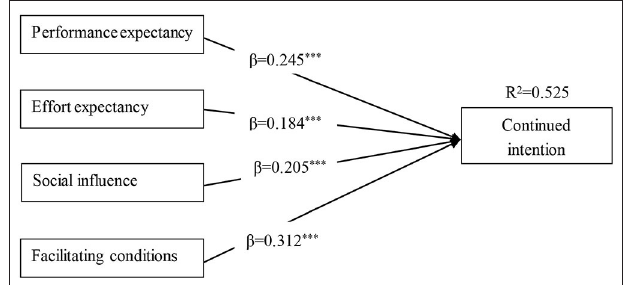
FIGURE 2 | Results of the proposed SEM. *** p <